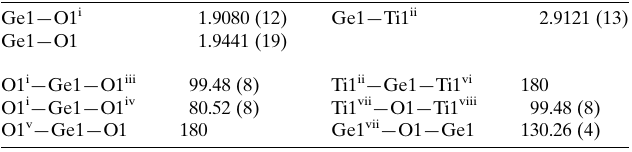
Table 1 Selected geometric parameters (A˚ , (cid:2) ).